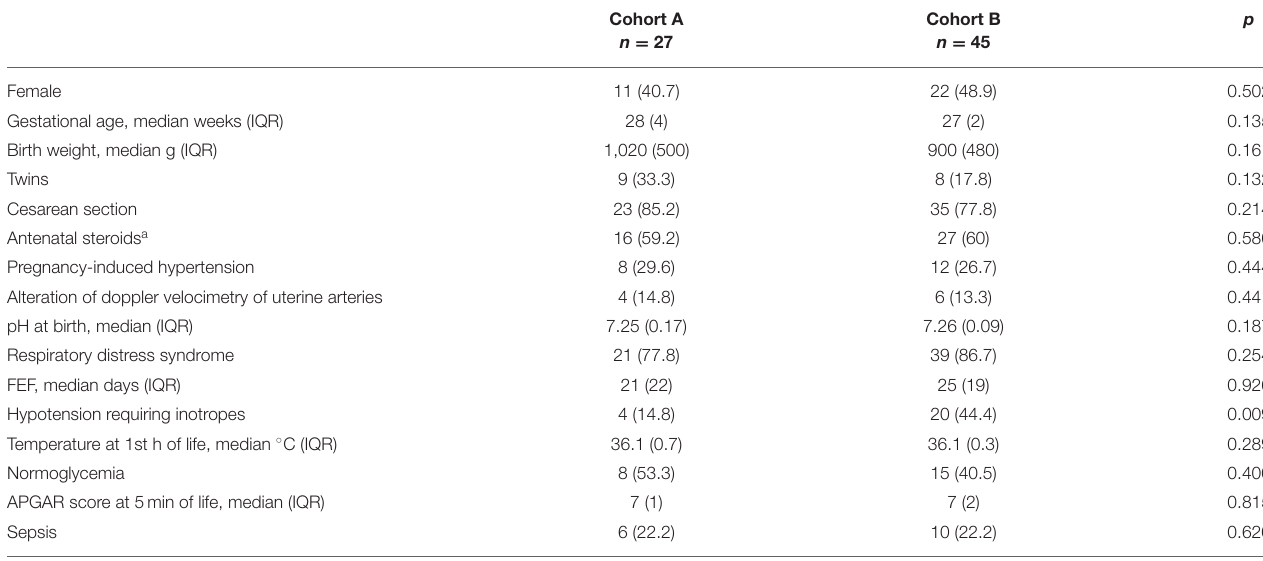
TABLE 1 | Baseline clinical characteristics of the study cohorts.